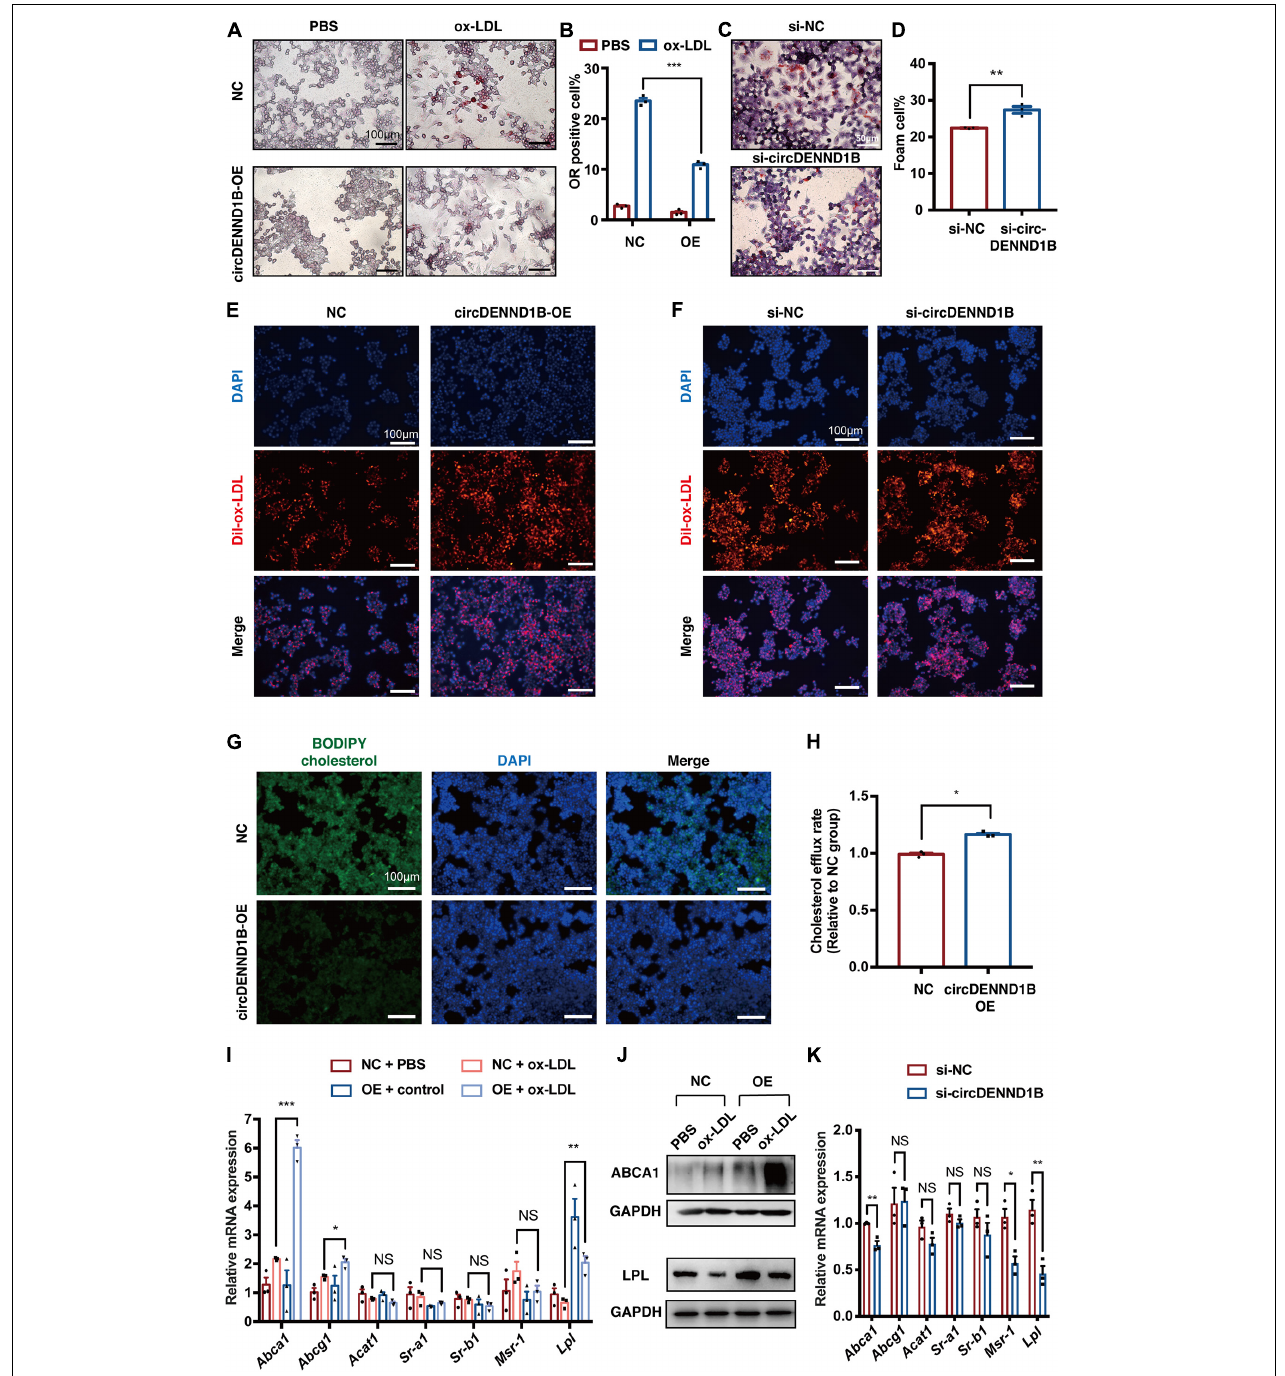
FIGURE 3 | circDENND1B regulates foam cell formation by promoting cholesterol efflux. (A) ORO staining showing that fewer foam cells are formed in RAW264.7 cells overexpressing circDENND1B. (B) The percentage of foam cells was lower after overexpressing circDENND1B. Approximately 1000 cells were counted per treatment over three separate experiments. (C) ORO staining showing that fewer foam cells are formed after knocking down circDENND1B. (D) The percentage of foam cells was higher after knocking down circDENND1B. Approximately 1000 cells were counted per treatment over three separate experiments. (E,F) Representative fluorescent images of cells treated with dil-ox-LDL for 48 h. Dil-ox-LDL positive cells were stained in red. (G) Representative images of the BODIPY assay showing overexpressing circDENND1B lowered cellular cholesterol. (H) Relative cholesterol efflux rate in cells overexpressing circDENND1B, measured by BODIPY assay. (I) qRT-PCR results of genes related to foam cell formation. Data were normalized to GAPDH ( n = 3 per group). (J) WB results of proteins related to foam cell formation after ox-LDL treatment. (K) qRT-PCR results of genes related to foam cell formation in RAW264.7 cells. Data were normalized to GAPDH ( n = 3 per group). NC: negative control. OE, overexpress; NS, no significant difference, * p < 0.05, ** p < 0.01, *** p < 0.001.